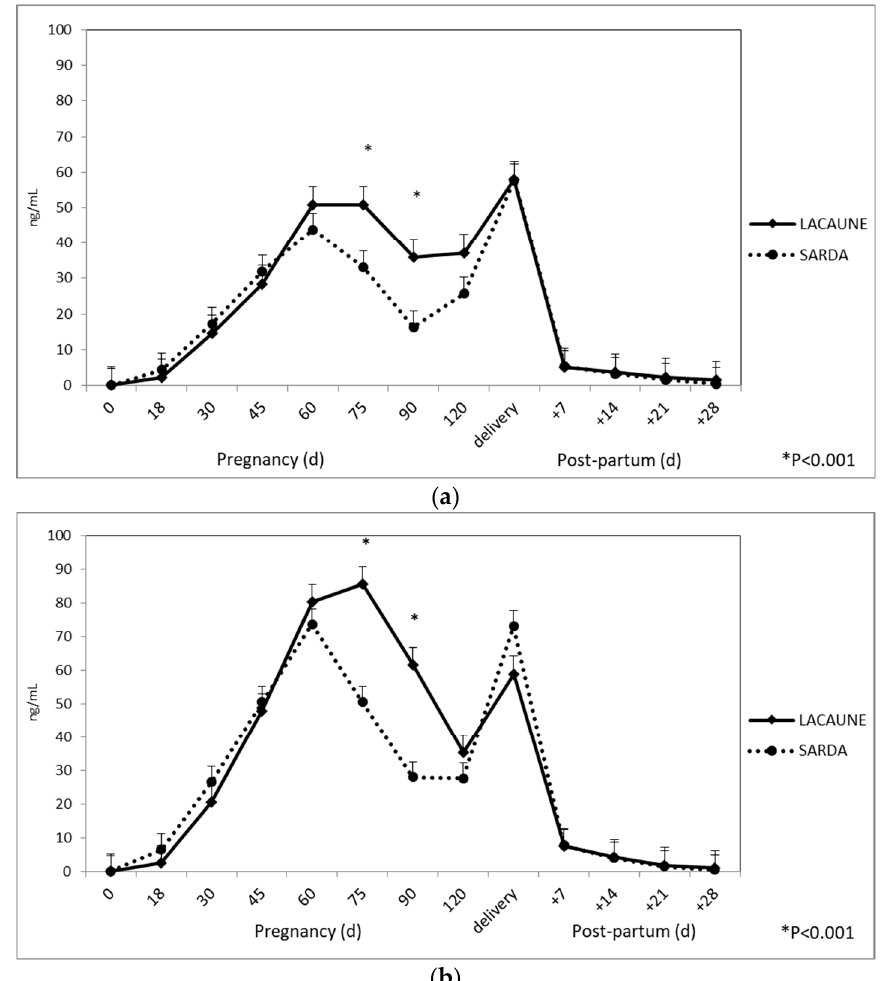
Figure 1. Plasma PAG profile in Lacaune and Sarda ewes during pregnancy and postpartum when using ( a ) RIA-706 and ( b ) RIA-srPool.